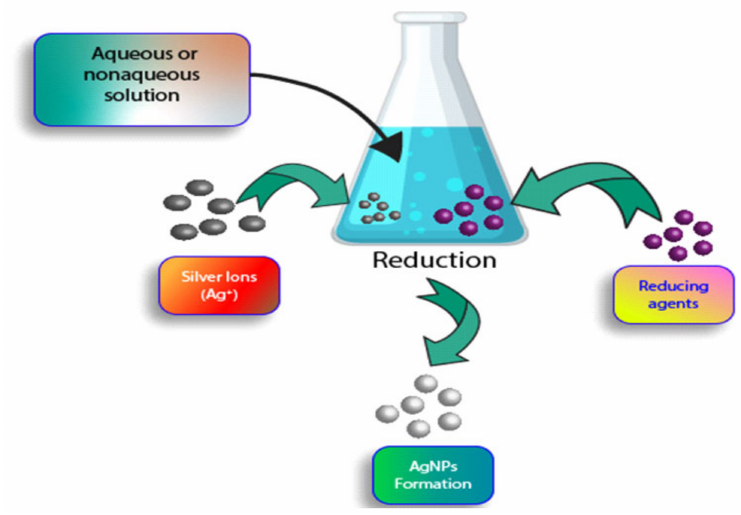
Figure 5. Chemical synthetization of silver nanoparticles through chemical